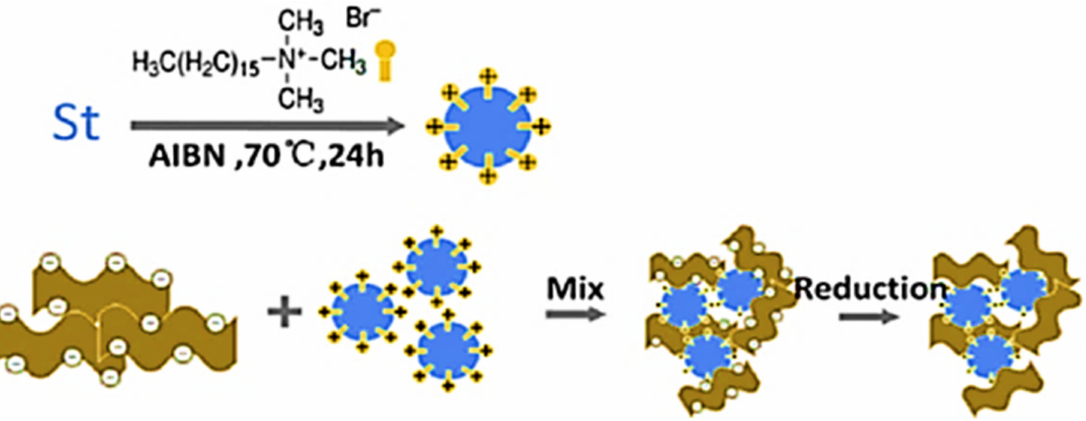
by 2.1 and 2.4 folds, respectively.